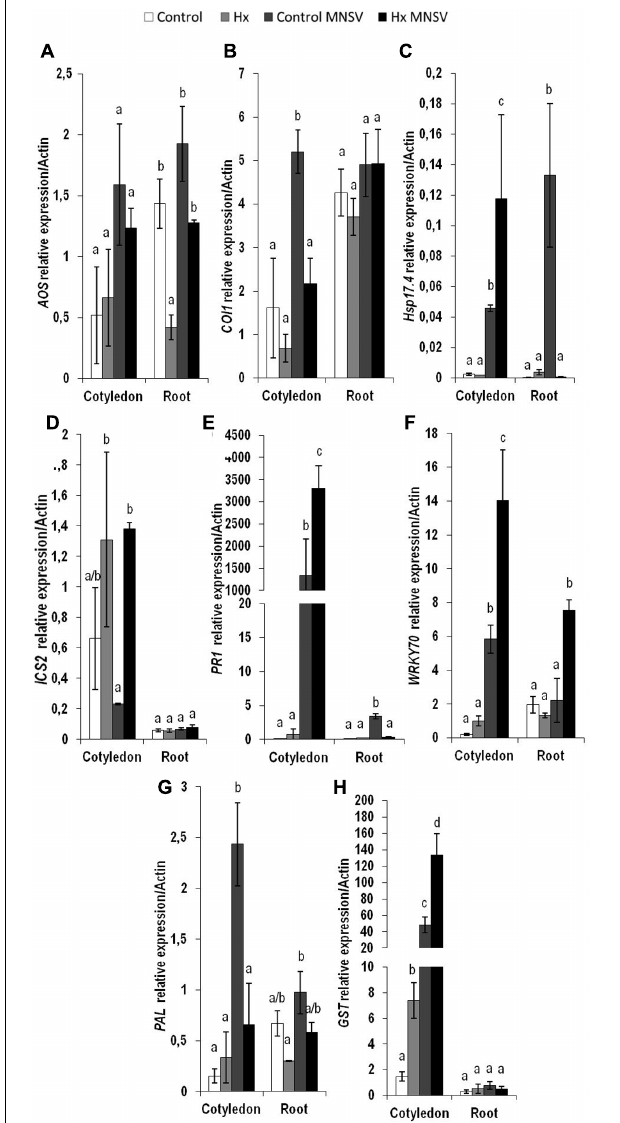
FIGURE 8 | Expression profile of the genes involved in plant defense pathways in the control and Hx-treated plants upon MNSV infection in middle infection stages. Plants were grown and inoculated as described in Figure 2C . Total RNA was isolated from roots and leaves at 5 hpi, converted into cDNA and subjected to a qRT-PCR analysis. The results were normalized to the Actin gene expression level measured in the same sample. The expression levels of genes (A) AOS , (B) COI1 , (C) Hsp17.4 , (D) ICS2, (E) PR1, (F) WRKY70 , (G) PAL , and (H) GST were analyzed. Data represent the mean ± SE of three independent experiments with 10 plants per experiment. Letters indicate statistically significant differences between treatments at each time point ( p < 0.05; least significant difference